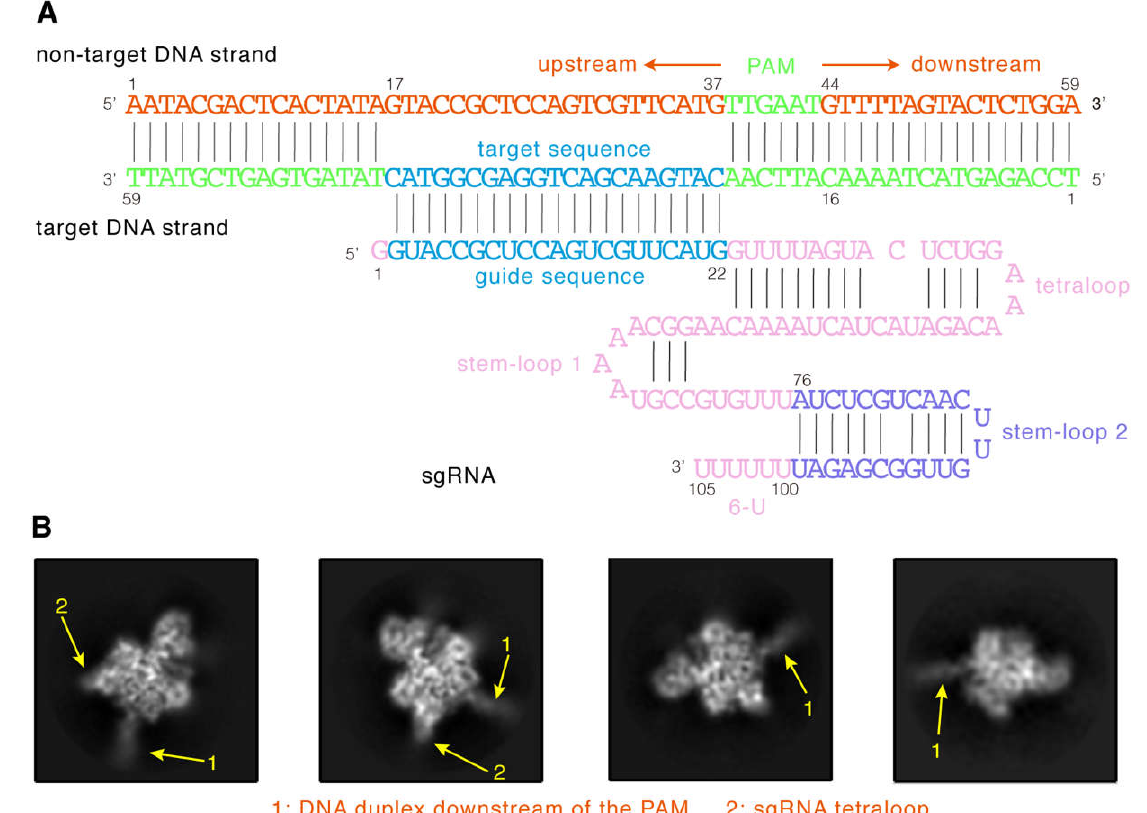
Figure 2. The cryo-EM structure of the ternary complex. ( A ) Schematic diagrams of 105 nt sgRNA and 59 bp target DNA of the ternary complex. ( B ) Representative 2D classes of the complex particles. The positions of the substrate DNA downstream of the PAM are indicated by arrows 1, and the positions of the sgRNA tetraloop are indicated by arrows 2.